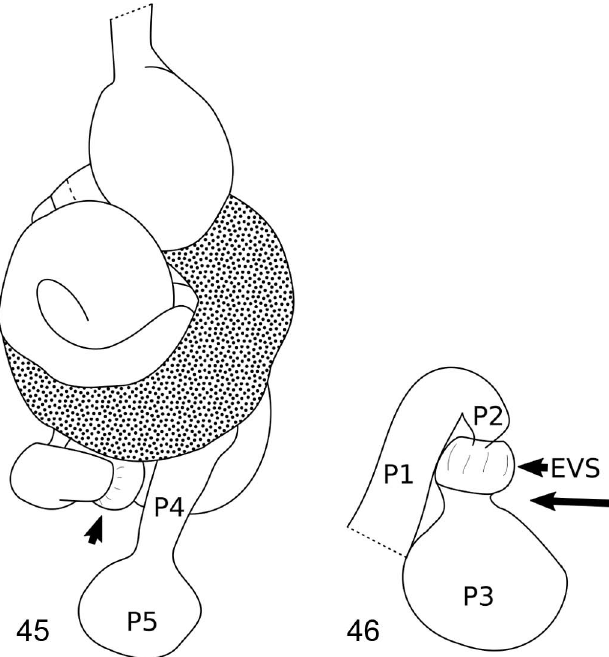
Figs 45–46. Worker gut in situ of Diversitermes diversimiles : 45- dorsal view; 46- detail of P3, in posterior view (EVS, short arrow, constriction, long arrow, figures not to